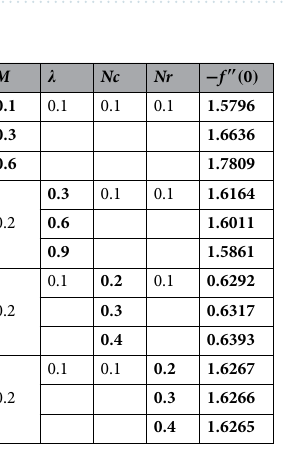
Figure 16. expounds the impacts of Lb on χ .